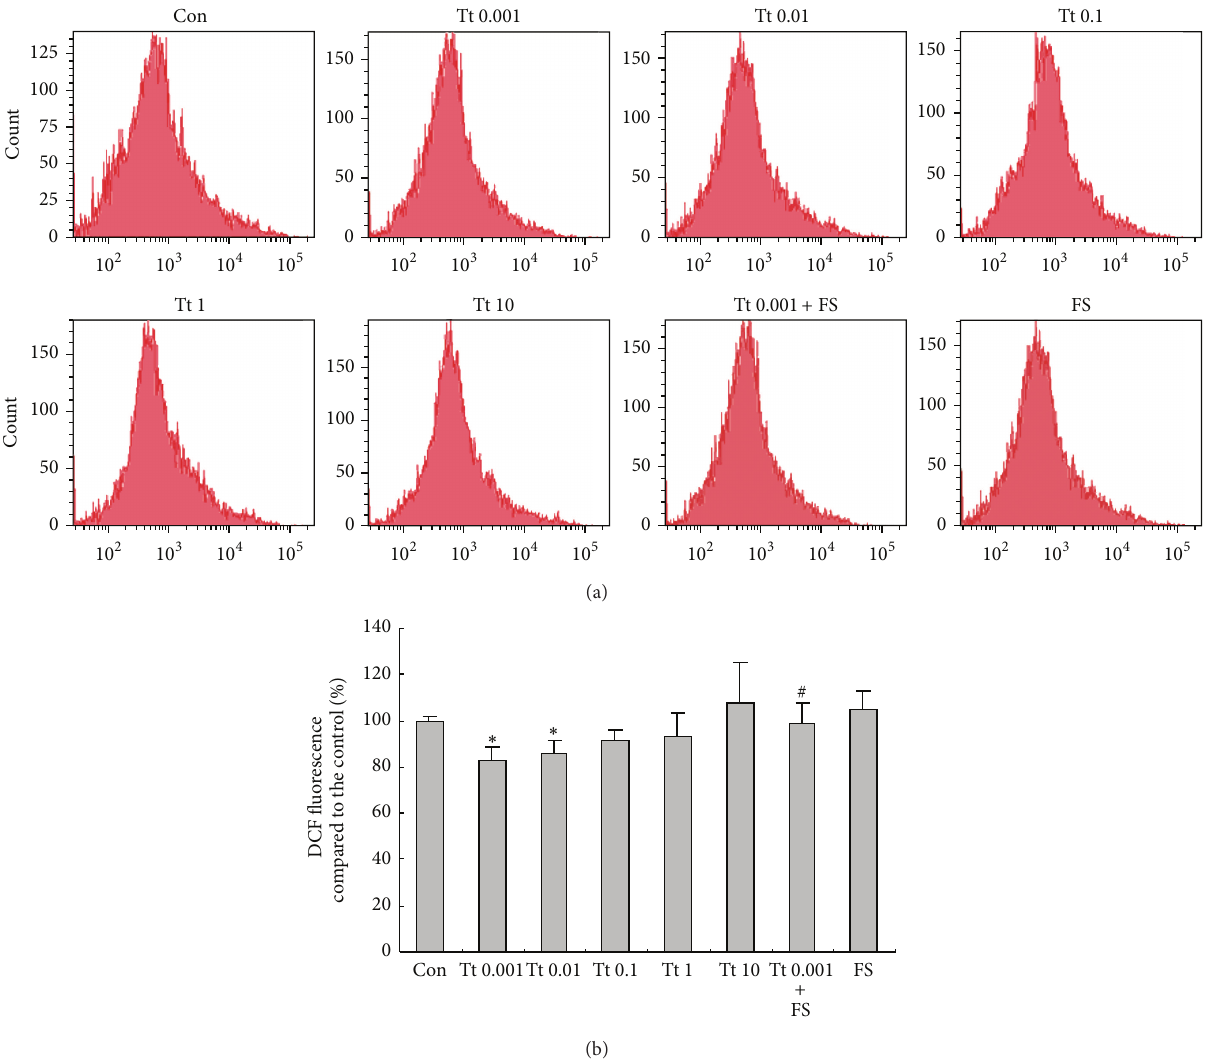
Figure 2: Effects of tryptase (Tt) on the generation of reactive oxygen species (ROS) from astrocytes. Astrocytes were exposed to different concentrations of tryptase(0.001, 0.01, 0.1, 1, and 10 𝜇 g/mL)in thepresence or absence of FSLLRY-NH2 (FS, 400 𝜇 M), an antagonist of tryptase at 37 ∘ C for 2 h. ROS was presented as changes of DCF fluorescence. Data are presented as the mean ± SEM analyzed from three independent sets of samples. ∗ 𝑃 < 0.05 versus control group (Con), # 𝑃 < 0.05 versus corresponding tryptase treatment group.